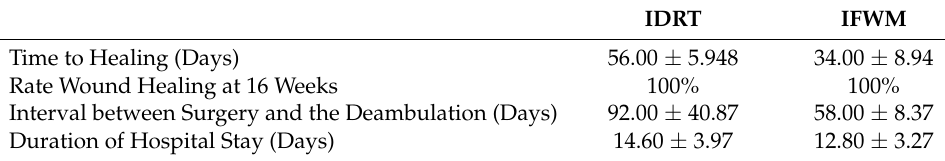
Table 5. Secondary endpoints in IDRT and